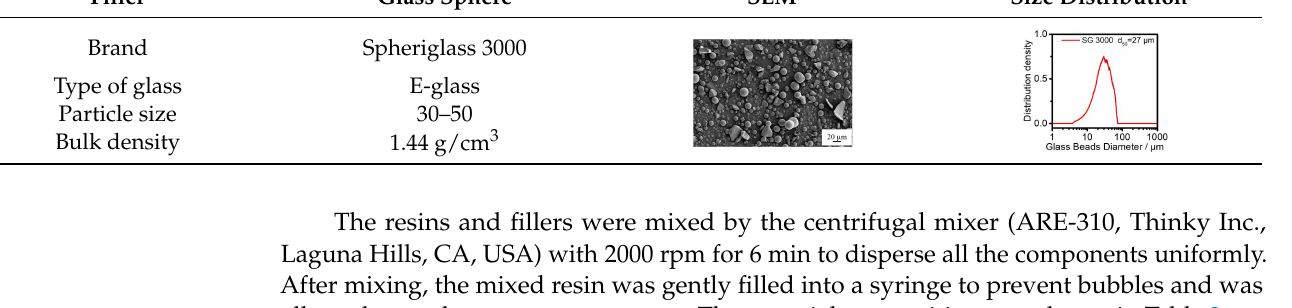
Table 2. Glass sphere. Filler